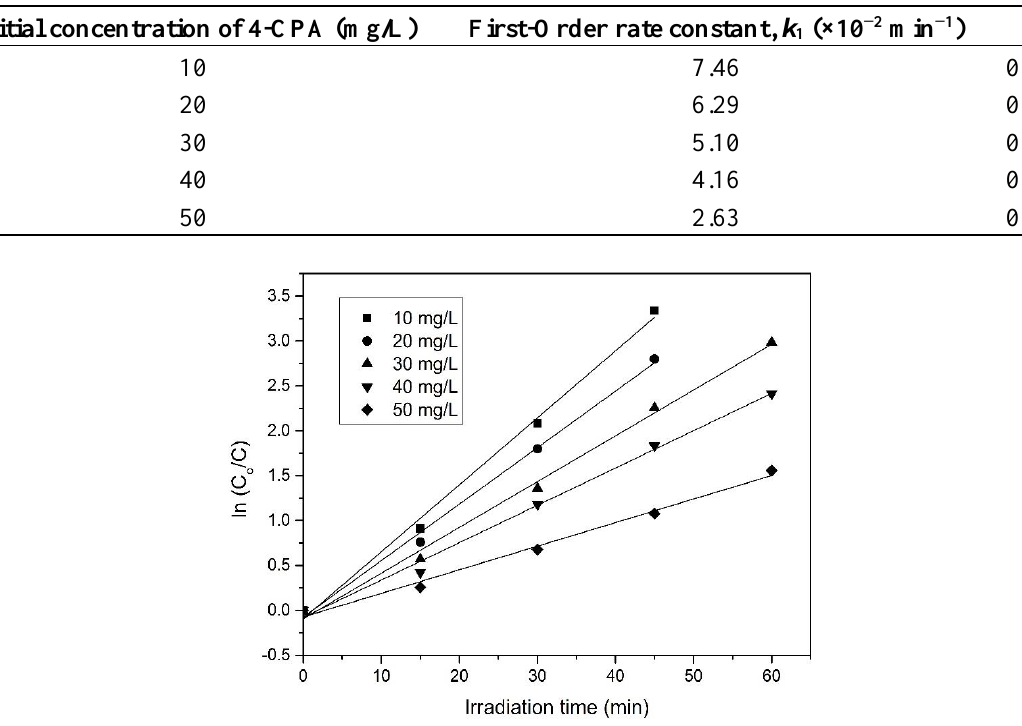
Figure 8. First-order rate graph of photocatalytic degradation on 4-CPA under UV illumination.